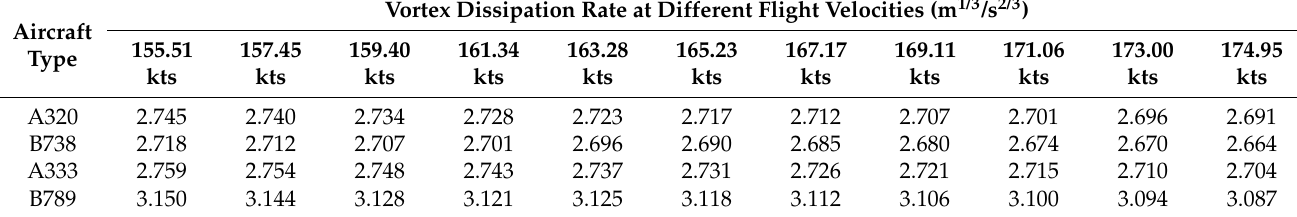
Table 4. Vortex dissipation rate of each aircraft at different velocities.